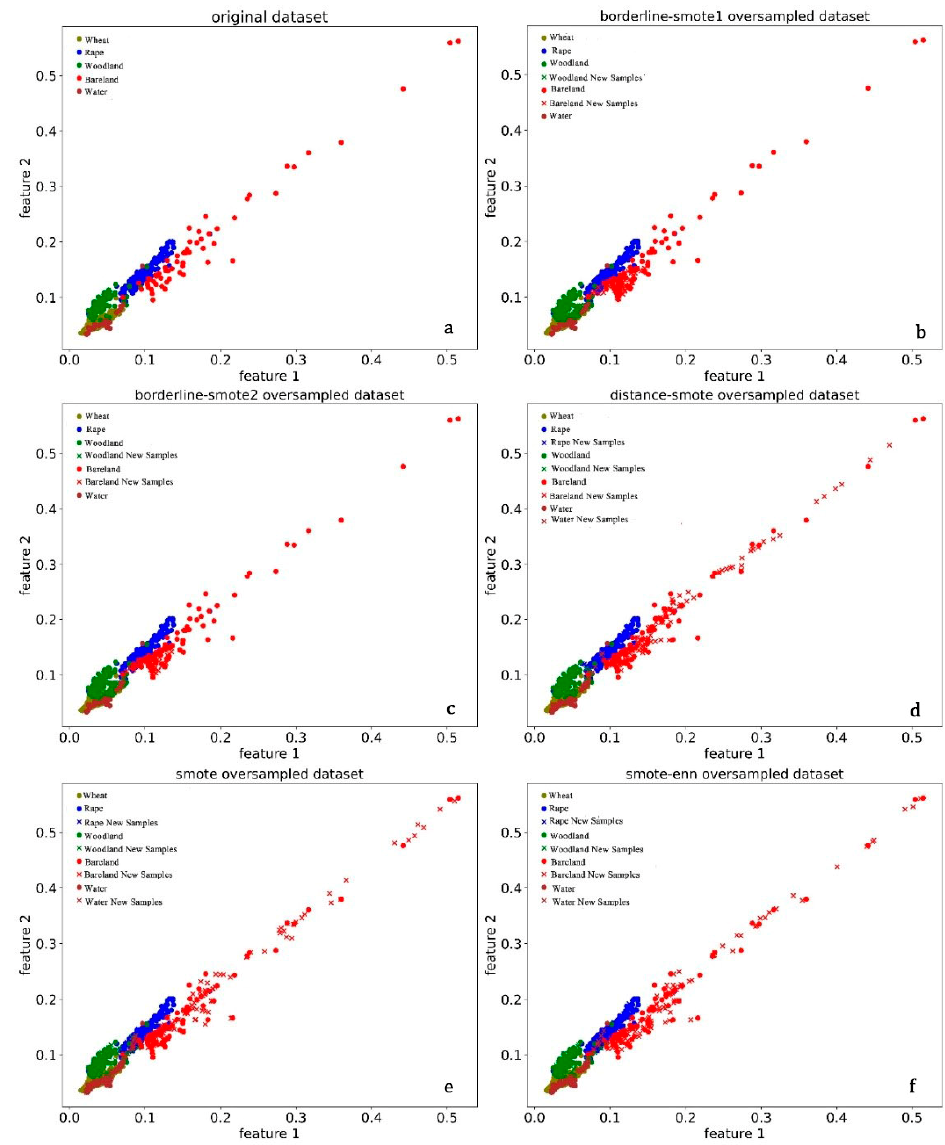
Figure 10. The origin dataset and five different oversampling datasets with wheat, rape, woodland, built-up, water and bareland. ( a ) origin dataset ( b ) borderline-smote1 dataset ( c ) borderline-smote2 dataset ( d ) distance-smote dataset ( e ) smote dataset ( f )